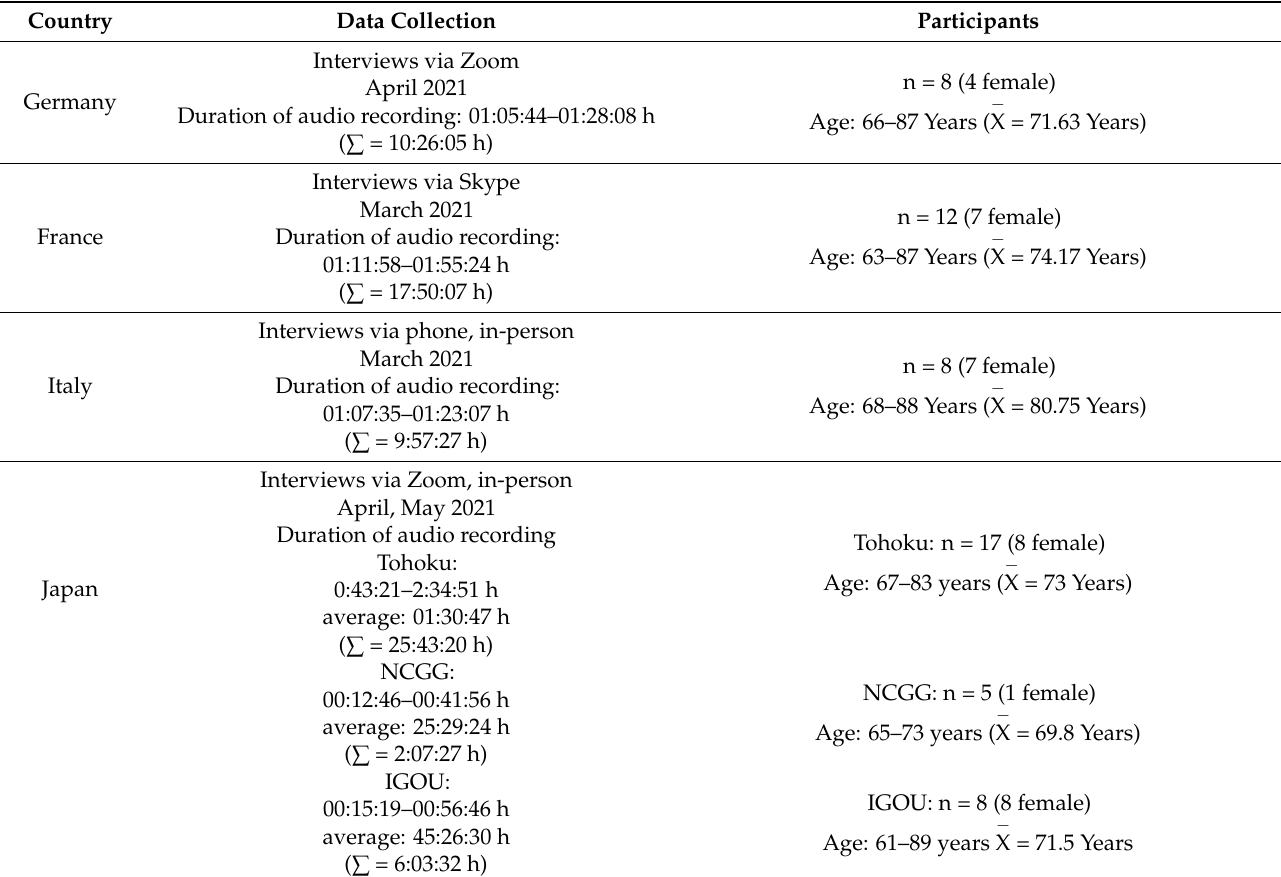
Table 1. Interview and participant